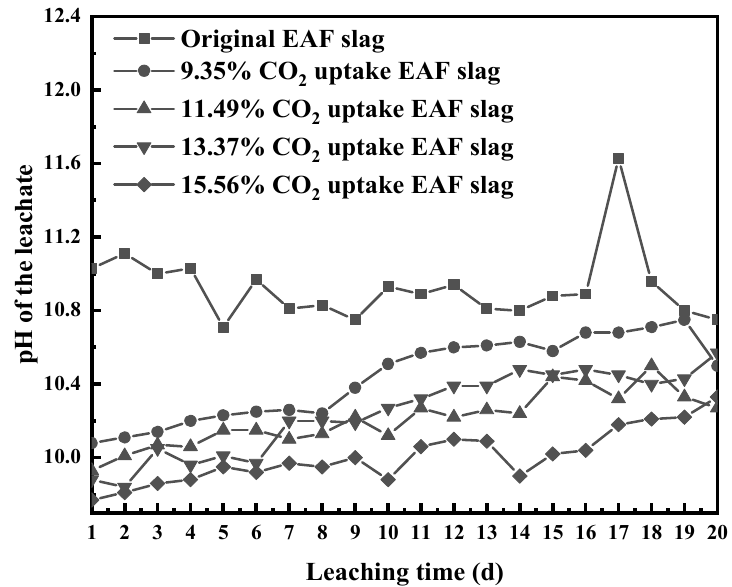
Figure 6. Evolution of leachates’ pH as a function of leaching time.